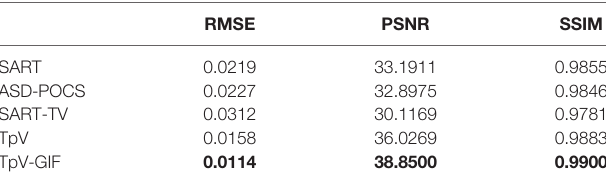
TABLE 3 | Quantitative evaluation of brain phantom reconstruction with 32-angle projection.